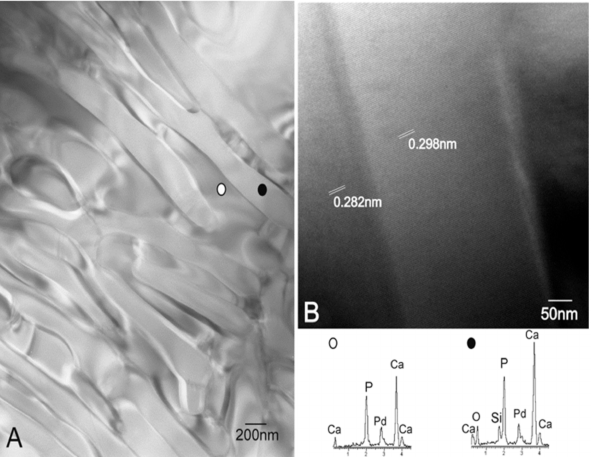
Figure 2. ( A ) Representative TEM image of the eutectoid scaffold surfaces and ( B ) the HRTEM image of the α -TCP-SC lamellae interphase and the EDS analysis. The scaffold cooled at 50 ◦ C/h was representative of all the